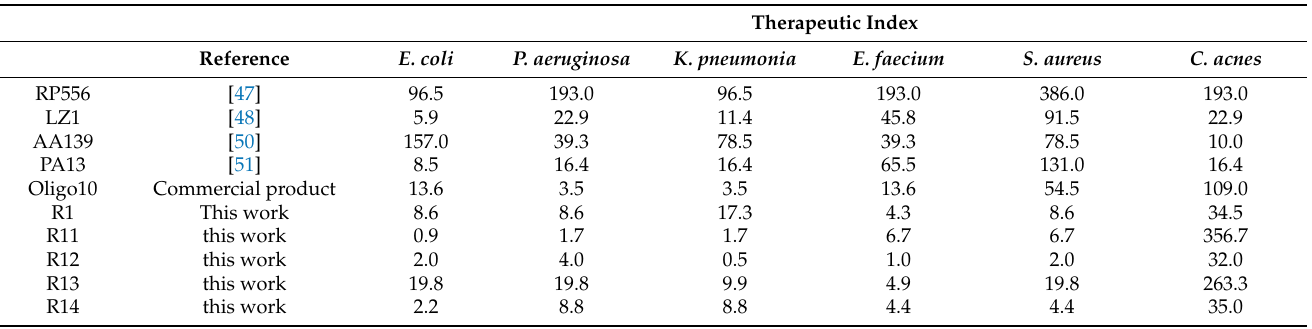
Table 3. Therapeutic indexes of antimicrobial peptides. Calculations done based on cytotoxicity (IC 50 ) in Balb/c 3T3 line and MIC values against listed bacteria.